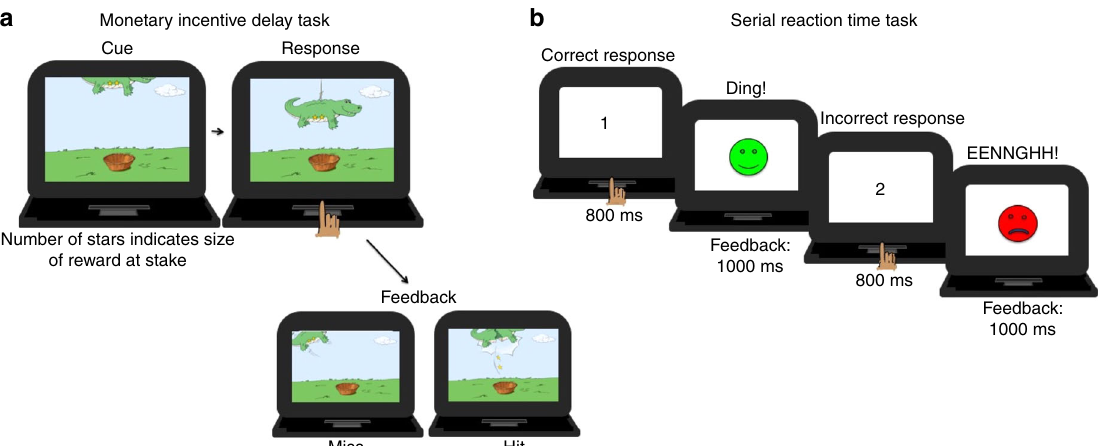
Fig. 1 Illustration of the MID and SRT tasks. a Schematic of the monetary incentive delay task (MID) used in this study showing each phase of a particular trial including presentation of the number of starts a child could earn on a speci fi c trial (screen 1) followed by the child ’ s response (screen 2) and the feedback (hit or miss — screens 3 and 4). Presentation time was modi fi ed based on each child ’ s performance on a practice task. Adapted with permission from ref. 34 . All rights reserved. b Schematic of the serial reaction time task showing two sample trials. On each trial a number (1 – 4) appeared for 800 ms, the child simply pressed the button on the keyboard that corresponded with that number. Next feedback occurred — a smiley face and pleasant sound if the keyboard press matched the presented number and a frowny face and unpleasant sound if the press did not match the presented